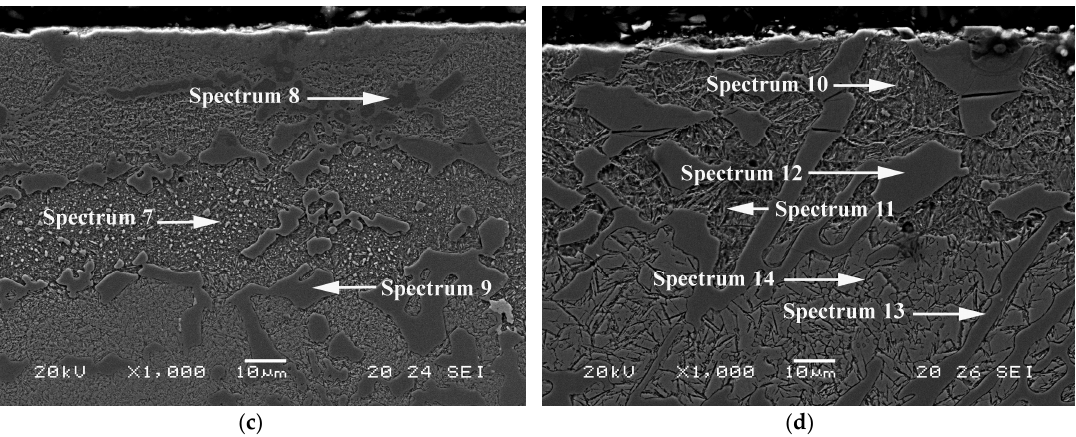
Figure 5. Phases and constituents in the nitrided layer analyzed by energy dispersive X-ray (EDX) microanalysis. ( a ) Experiment 5; ( b ) Experiment 6; ( c ) Experiment 7; ( d ) Experiment 8. Table 6. Semi-quantitative analysis of the phases listed in Figure 5, determined by characteristic energy dispersive X-ray (EDX) microanalysis. (% in weight). Figure Exp. Spectrum